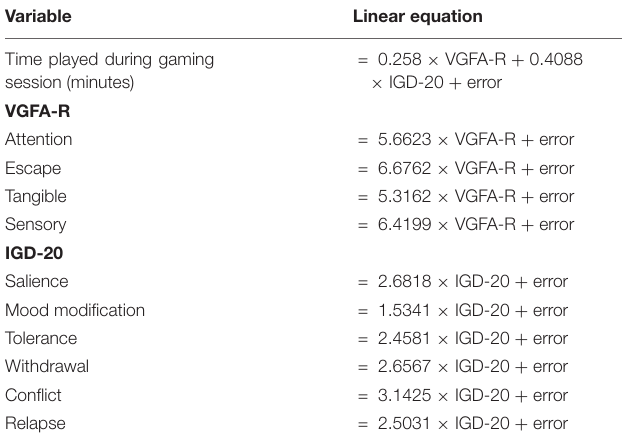
TABLE 3 | Structural equation model linear equations. Variable Linear